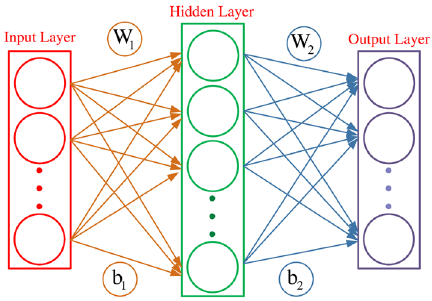
Figure 4. A simplified two-layer neural network. The circles represent the neurons at each layer of the neural network, corresponding to the nodes in the complex network. The correlations between neurons correspond to edges, and the different feedback intensities between neurons correspond to edge weights in the complex network.